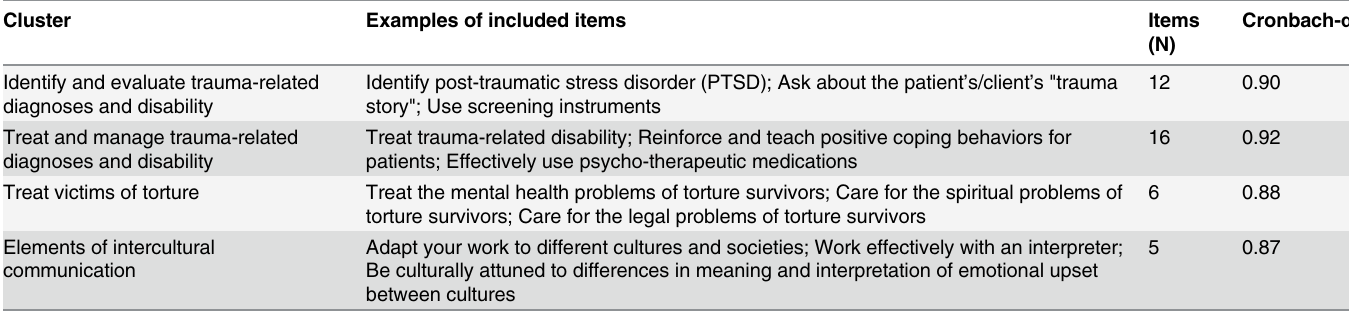
Table 1. The four generated clusters of con fi dence with examples of items, number of included items (n) and Cronbach ’ s α . Cluster Examples of included